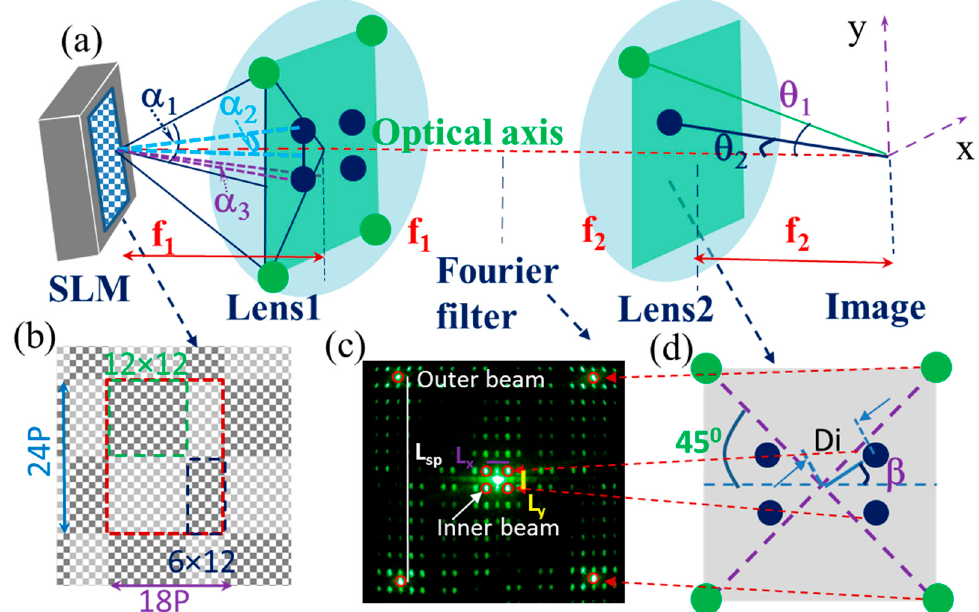
Figure 2. ( a ) Schematic of the optical setup for the holographic fabrication. The spatial light modulator (SLM) is used to display the phase patterns. The diffracted beams from the SLM are filtered at the Fourier plane and form interference patterns through a 4f imaging system of lens 1 and lens 2. α 1 , α 2 , and α 3 are the first order diffraction angles due to the periodic array of 2P (“P” is the side length of a pixel square = 8 µ m, which has been used in this paper) pixels in x and y directions, 24P pixels in y direction, and 18P pixels in x-direction in the phase pattern in ( b ), respectively. θ 1 and θ 2 (zenith angle) are the interfering angles of the outer beam and inner beams in ( c ), respectively. ( b ) An enlarged view of the designed phase patterns. A unit super-cell is indicated by the dashed red square. Inside the unit-cell, there are two 12 × 12 square pixel patterns and two 12 × 6 square pixel patterns. The gray levels of (190 and 254) correspond to the dashed green and blue regions, while (128 and 254) correspond to the remaining regions inside the unit super-cell. ( c ) The laser diffraction pattern from the phase pattern in ( b ) at the Fourier plane. A Fourier filter is used to allow the diffraction spots inside the red circles passing through. ( d ) Schematic of eight beams corresponding to the outer and inner beams in ( c ) for the interference lithography. β is an azimuthal angle for one of inner beams in ( c ). A unit super-cell of the phase pattern is indicated by a dashed red square in Figure 2b. The unit super-cell was divided into two 12 × 12 checkerboard regions and two 12 × 6 checkerboard regions. The gray levels of (190 and 254) are used for the regions inside the dashed green and blue squares, while (128 and 254) are used for the regions outside of the dashed green and blue squares in the unit